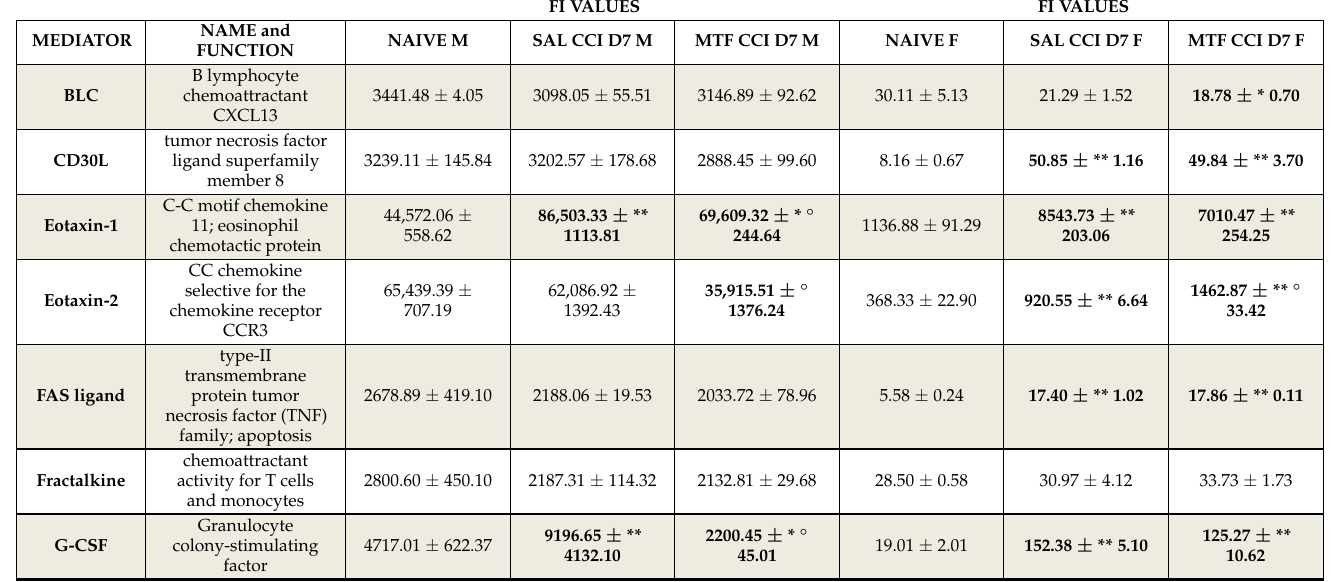
Table 1. Cytokines Changes at D7 After CCI in Naïve and Injured Sciatic Nerve of Saline or MTF- Treated Male and Female Mice. FI VALUES FI